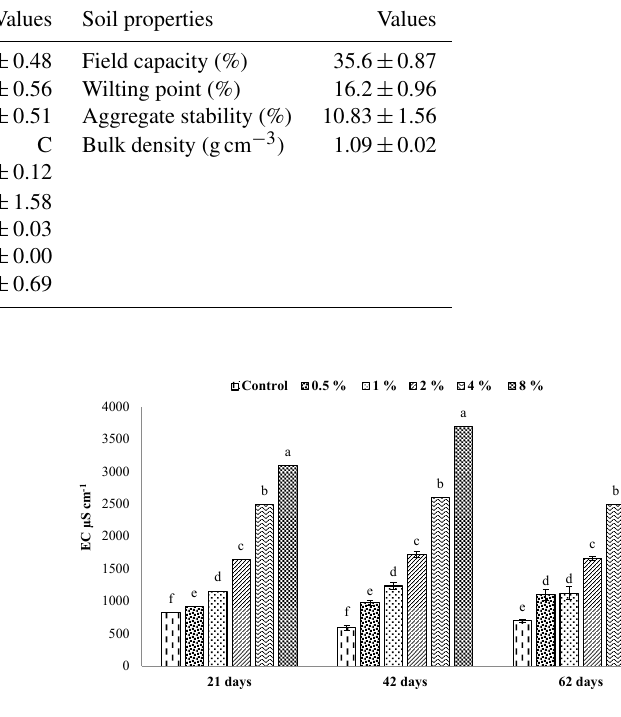
Figure 4. Effects of different rates of SMC application on soil EC (mean ± SD<0.05). Means followed by the same letter are not sta- tistically different as determined by a least significant difference